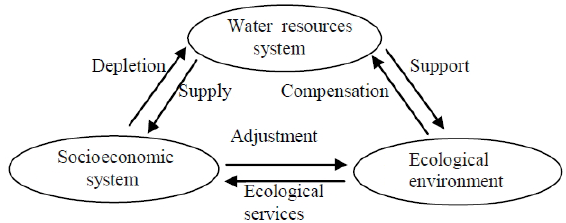
Figure 1. System feedback